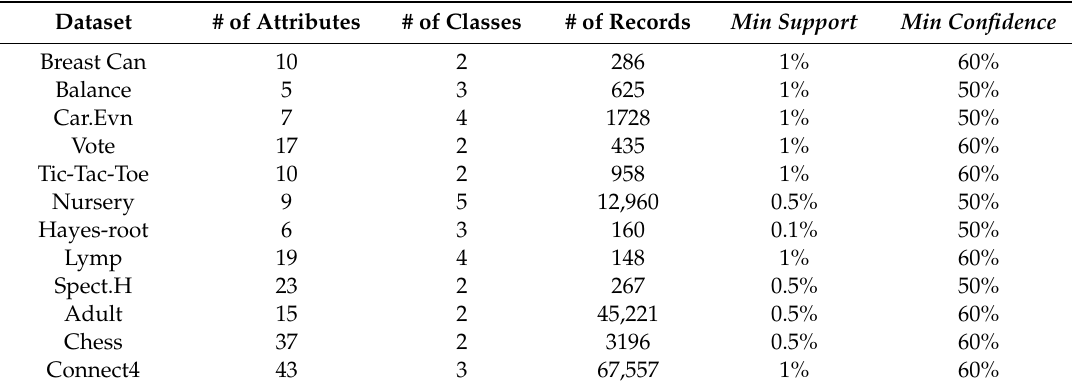
Table 5. Description of datasets and AC algorithm